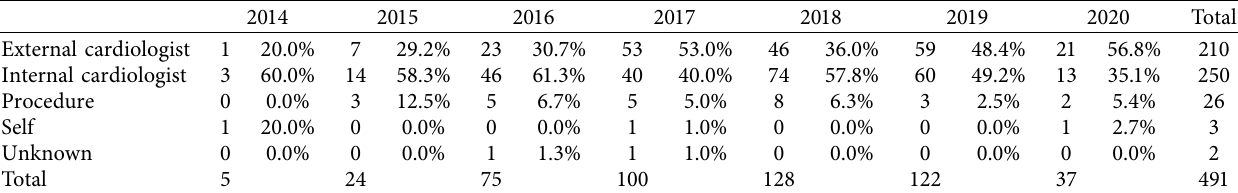
Table 3: Referral patterns for 491 patients undergoing TAVR at a single institution.